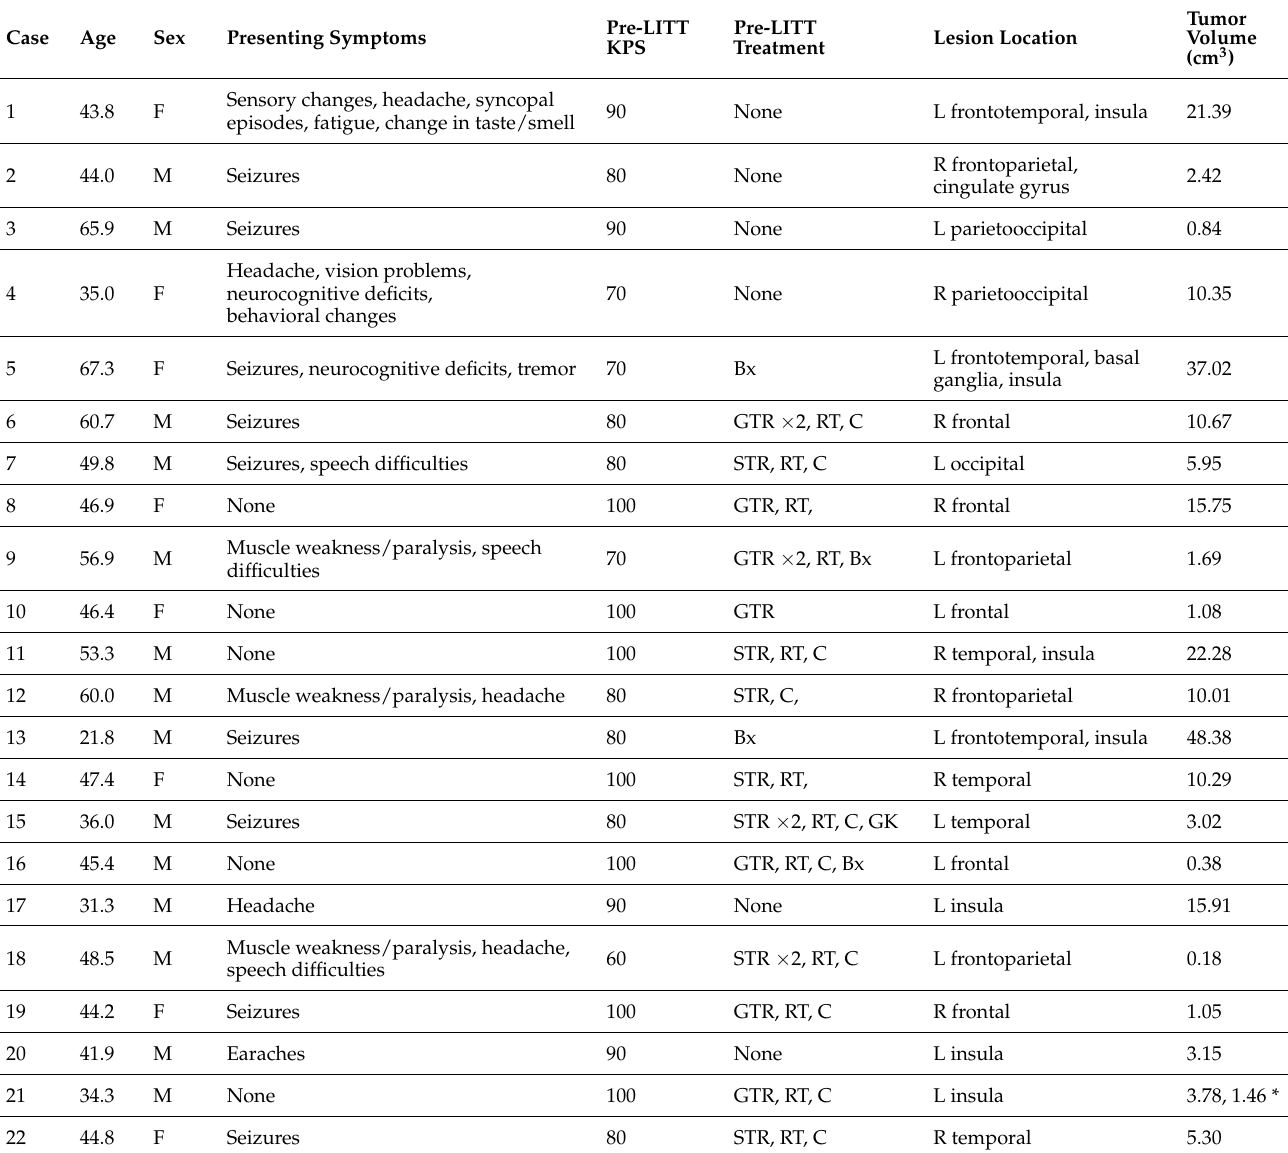
Table 1. Cohort demographics and initial